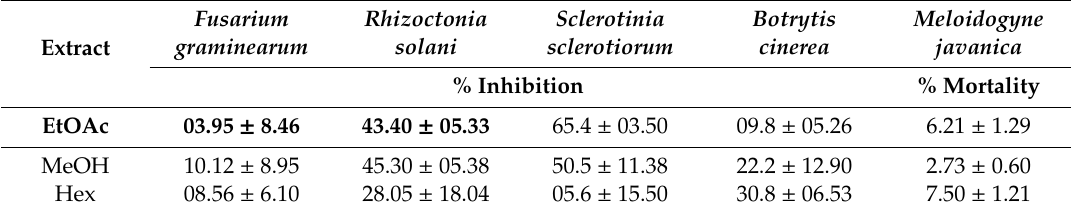
Table 1. Screening of bioactivity of Trichoderma sp. EFI 671 ethyl acetate (EtOAc), methanol (MeOH) and hexane (Hex) extracts against plant pathogens and parasites at 1 mg · mL − 1 concentration. Data are expressed as % mycelium growth inhibition (fungal pathogens) and % mortality ( M. javanica ).